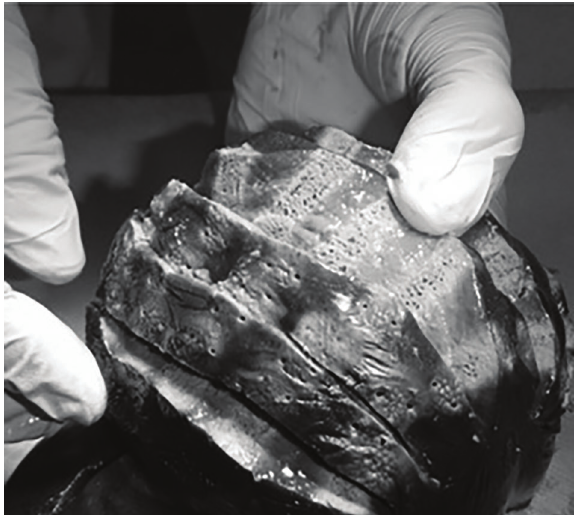
Figure 2. Ex vivo study. Application of the new laparoscopic device caused coagulation necrosis in the liver